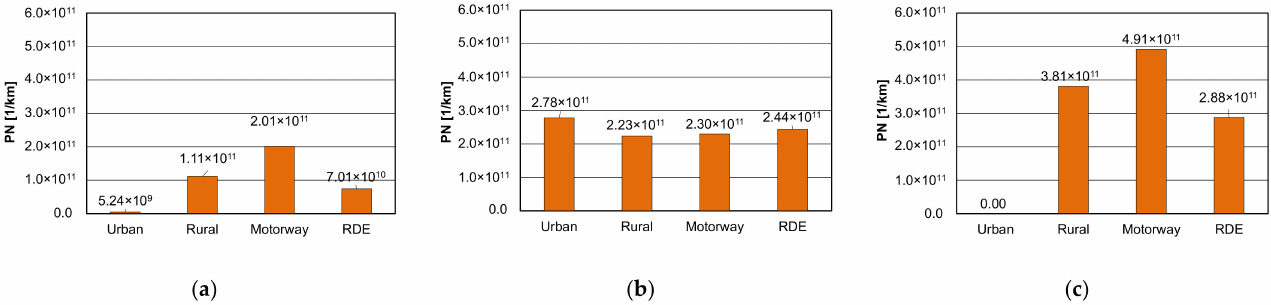
Figure 11. Results of tests of particle number on-road emission in a passenger vehicle with a gasoline engine ( a ), a diesel engine ( b ), PHEV ( c